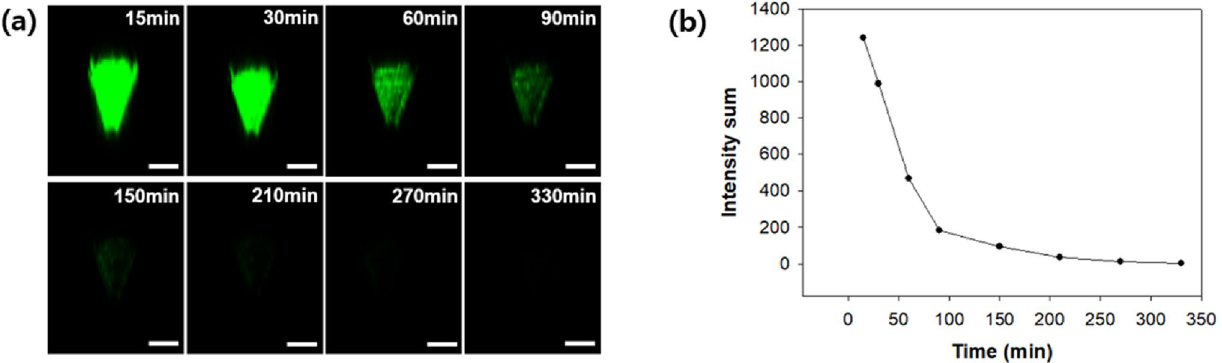
Figure 4. ( a ) Fluorescence image on the microneedle surface observed with a confocal microscope at 15, 30, 60, 90, 150, 210, 270, and 330 min (scale bar = 200 μm). ( b ) Change in fluorescence intensity on the surface of microneedle tips from 15 to 330